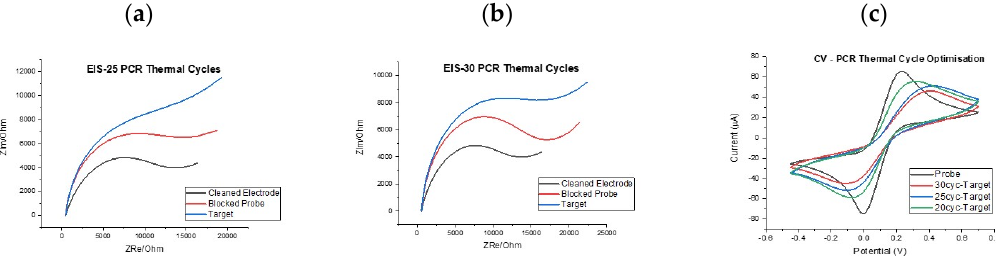
Figure 5. EIS responses for clean, probe modified and target bound electrodes following 25 PCR cycles ( a ) and 30 PCR cycles ( b , c ) CV results showing the correlation between oxidative and reductive peak currents and PCR cycle number.